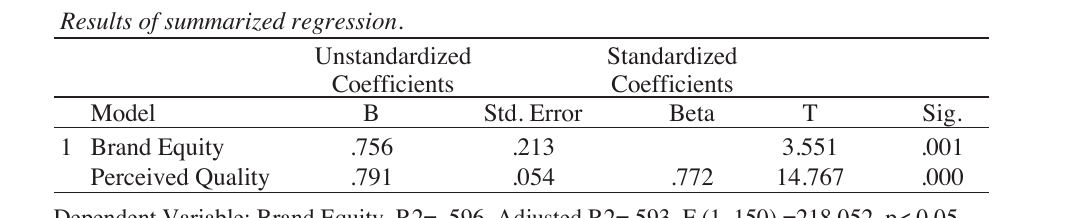
Results of summarized